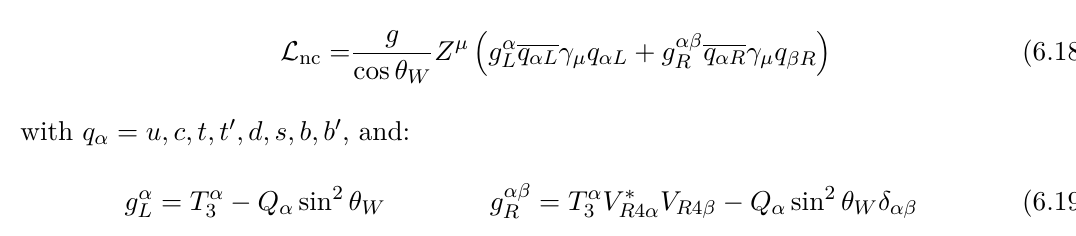
= 0 . 22444(35) , while using determination C Lus = − 1 . 16(37) × 10 − 3 , V Rus